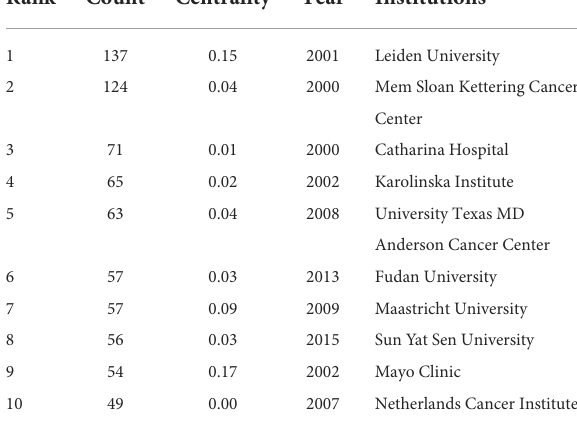
TABLE 1 Ranking of institutions according to number of published